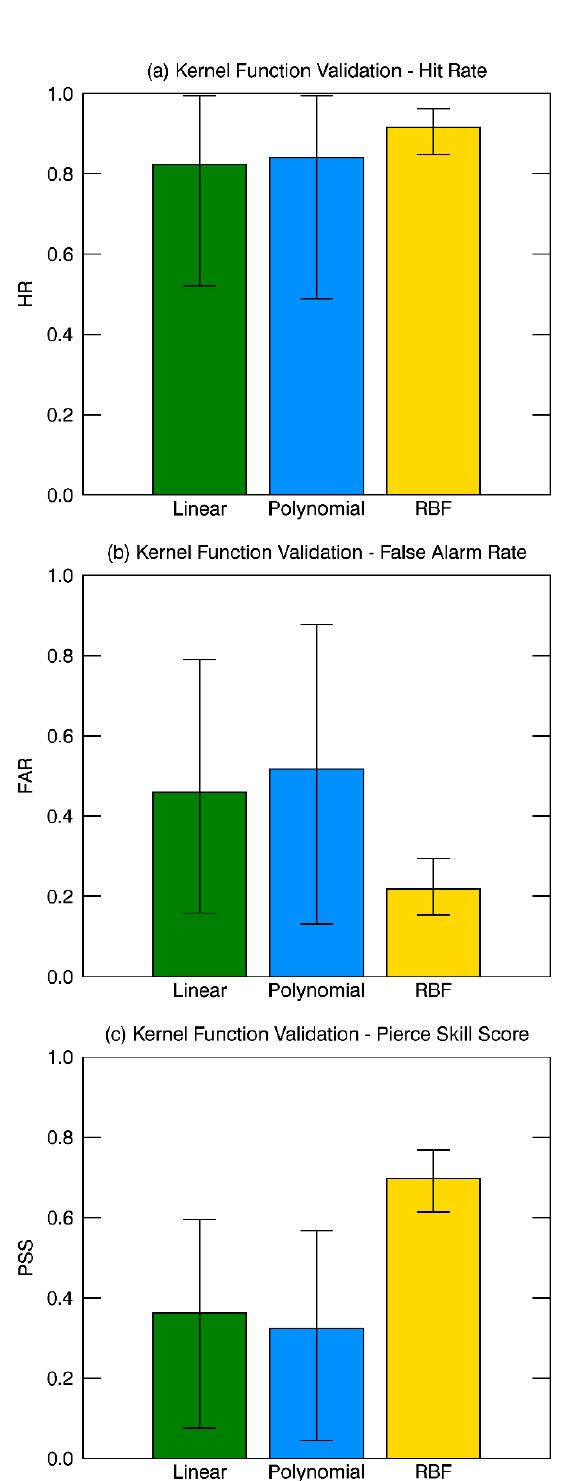
Figure 4. The comparison of the kernel function selected as linear (green), polynomial (blue), and radial basis function (yellow) in the support vector machines (SVM) model. Filled bars in ( a ) HR, ( b ) false alarm rate (FAR), and ( c ) Peirce Skill Score (PSS) represents the median values from the calibration tests for 1000 times. The 90 and 10 percentile values are also shown in each bar graph.